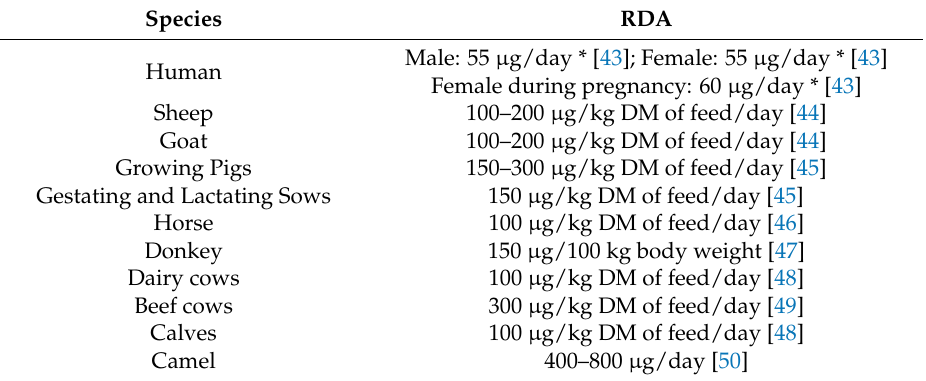
Table 2. Recommended Dietary Allowance (RDA) of selenium for human and different animal